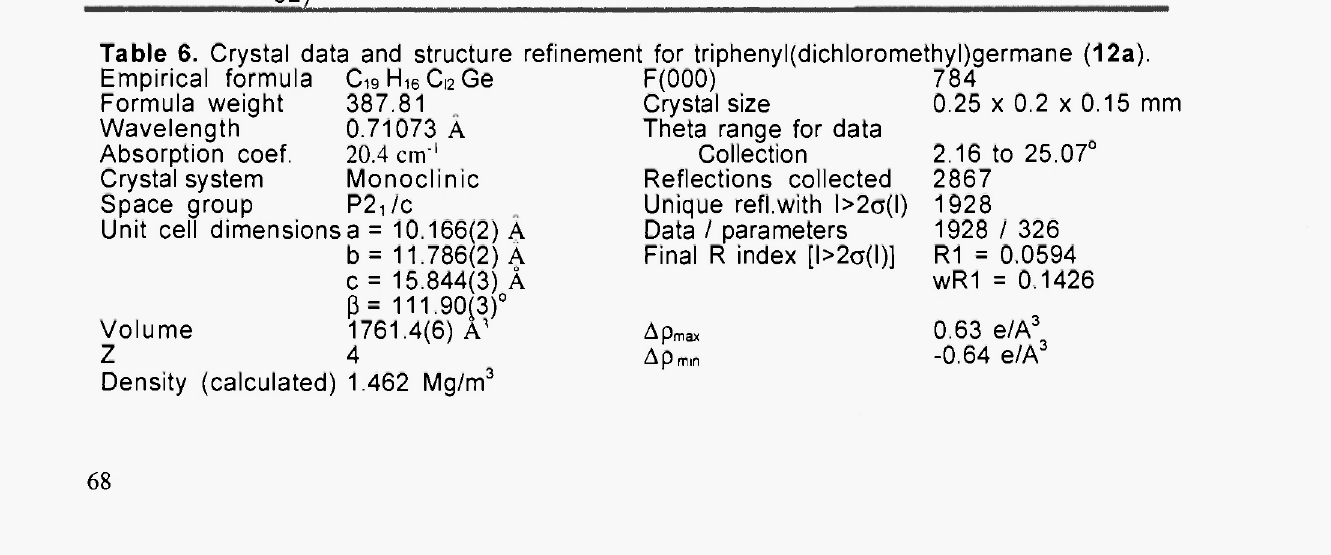
Table 6. Crystal data and structure refinement for triphenyl(dichloromethyl)germane (12a). Empirical formula Formula weight Wavelength Absorption coef. Crystal system Space group